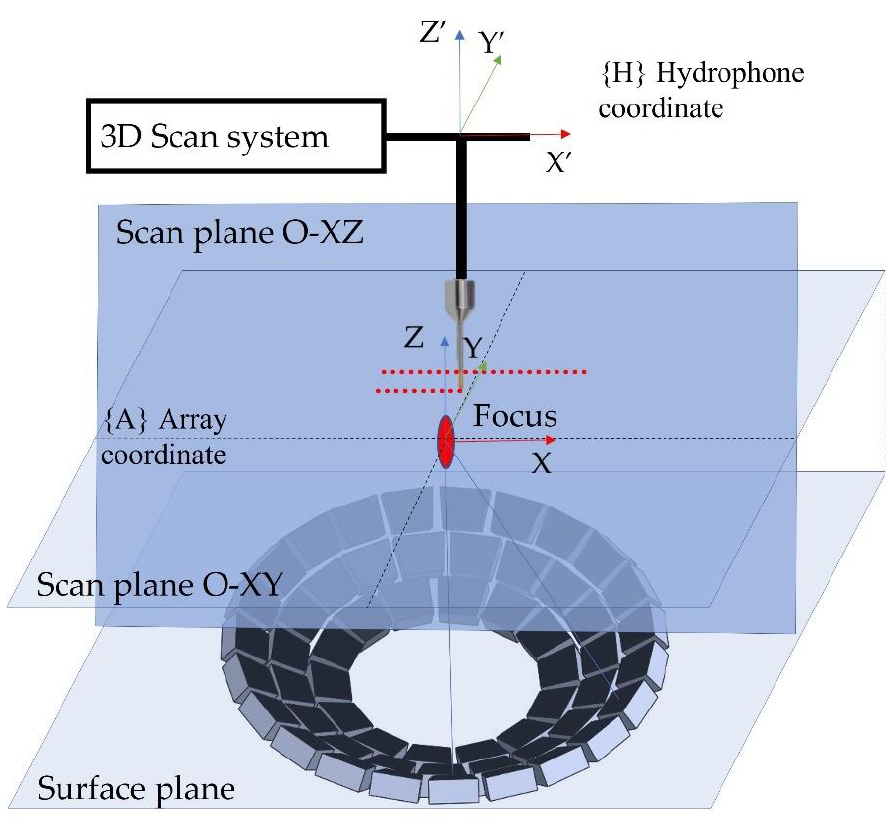
Figure 3. Holography measurement setup for the UA.